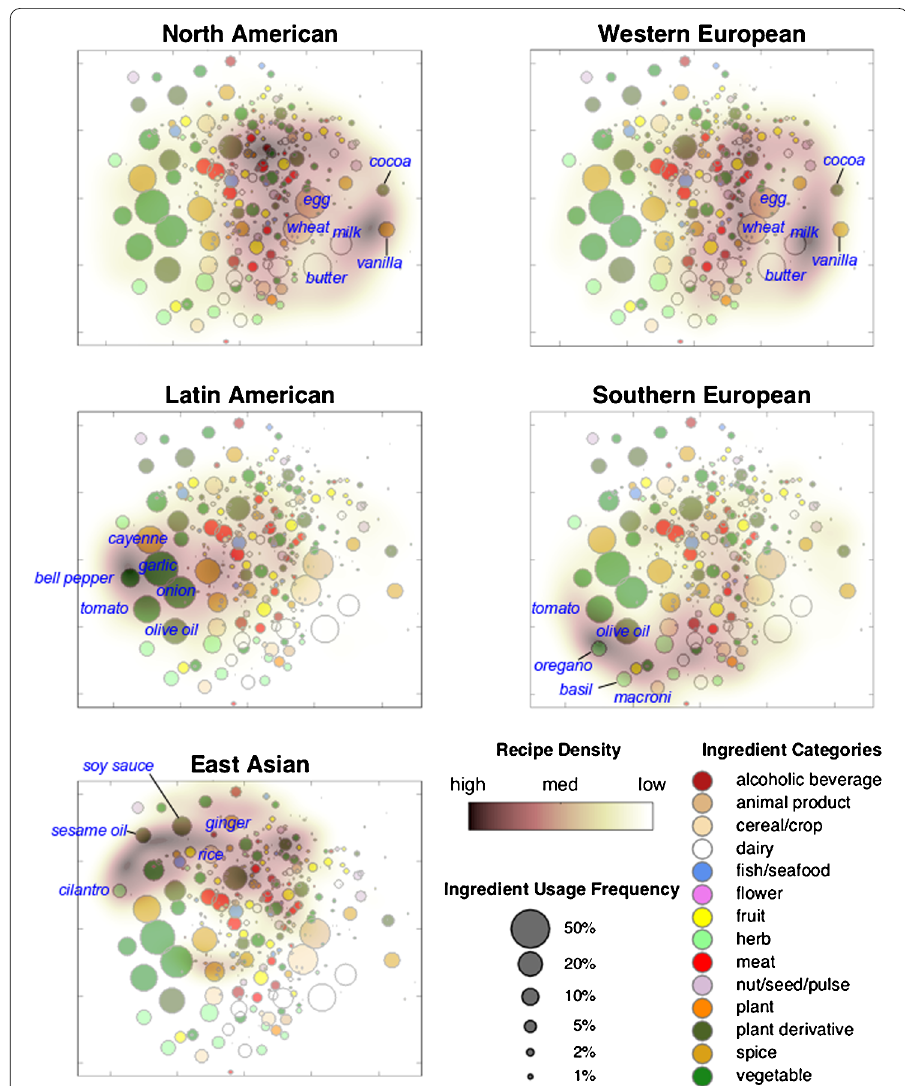
Figure 5 BiFold visualization of recipes and ingredients. Ingredients are plotted as circles with area proportional to the frequency of usage in recipes and coloring indicating its category. For each of the five cuisines (North American, Western European, Latin American, Southern European, and East Asian) we plot a density plot of the recipes from that cuisine along with the full set of ingredients. The BiFold layout enables visual exploration of the joint recipe-ingredient space across cuisines. For example, the central cloud contains protein groups (primarily meat) shared by all cuisines. Each cuisine is visually associated with a few “signature” ingredients, with examples include basil and oregano (Southern European), sesameoil and soysauce (East Asian), and so on. The BiFold plots allow us to “see” that certain cuisines are likely similar (North American - Western European, and Latin American - Southern